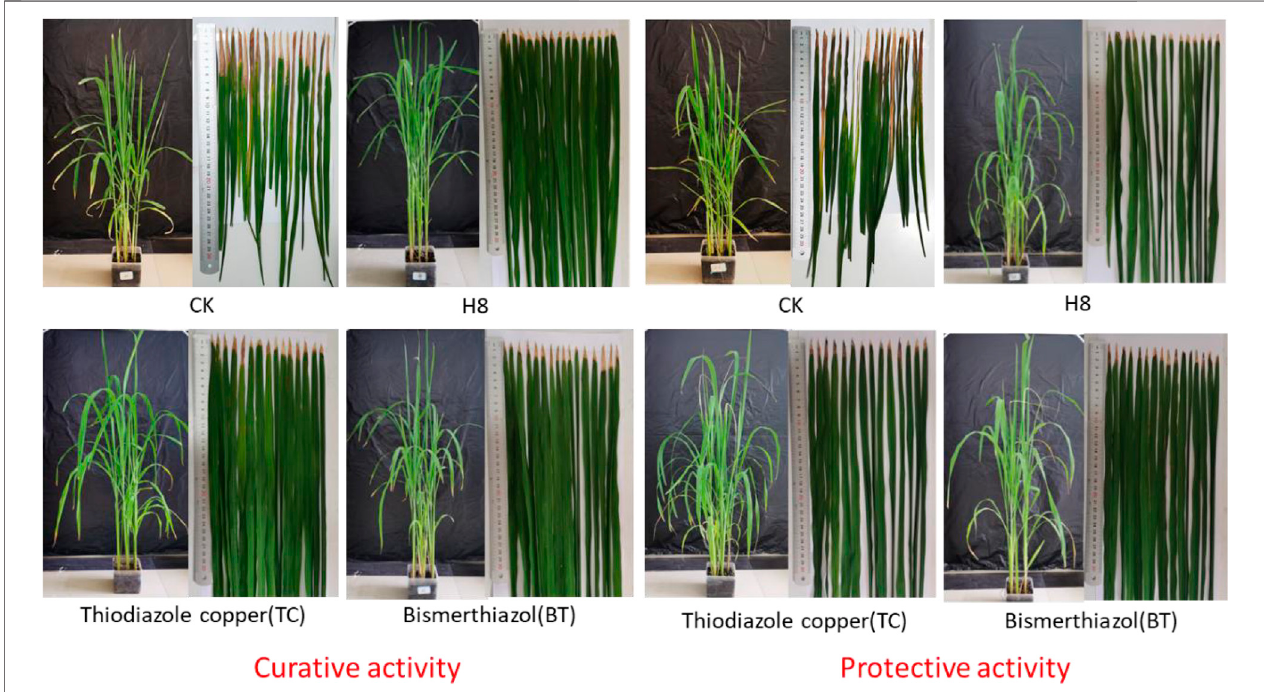
FIGURE 2 | Curative and protective activities of compound H8 against rice bacterial leaf blight under greenhouse conditions at 200 μ g /ml, with BT and TC as the positive control agents.